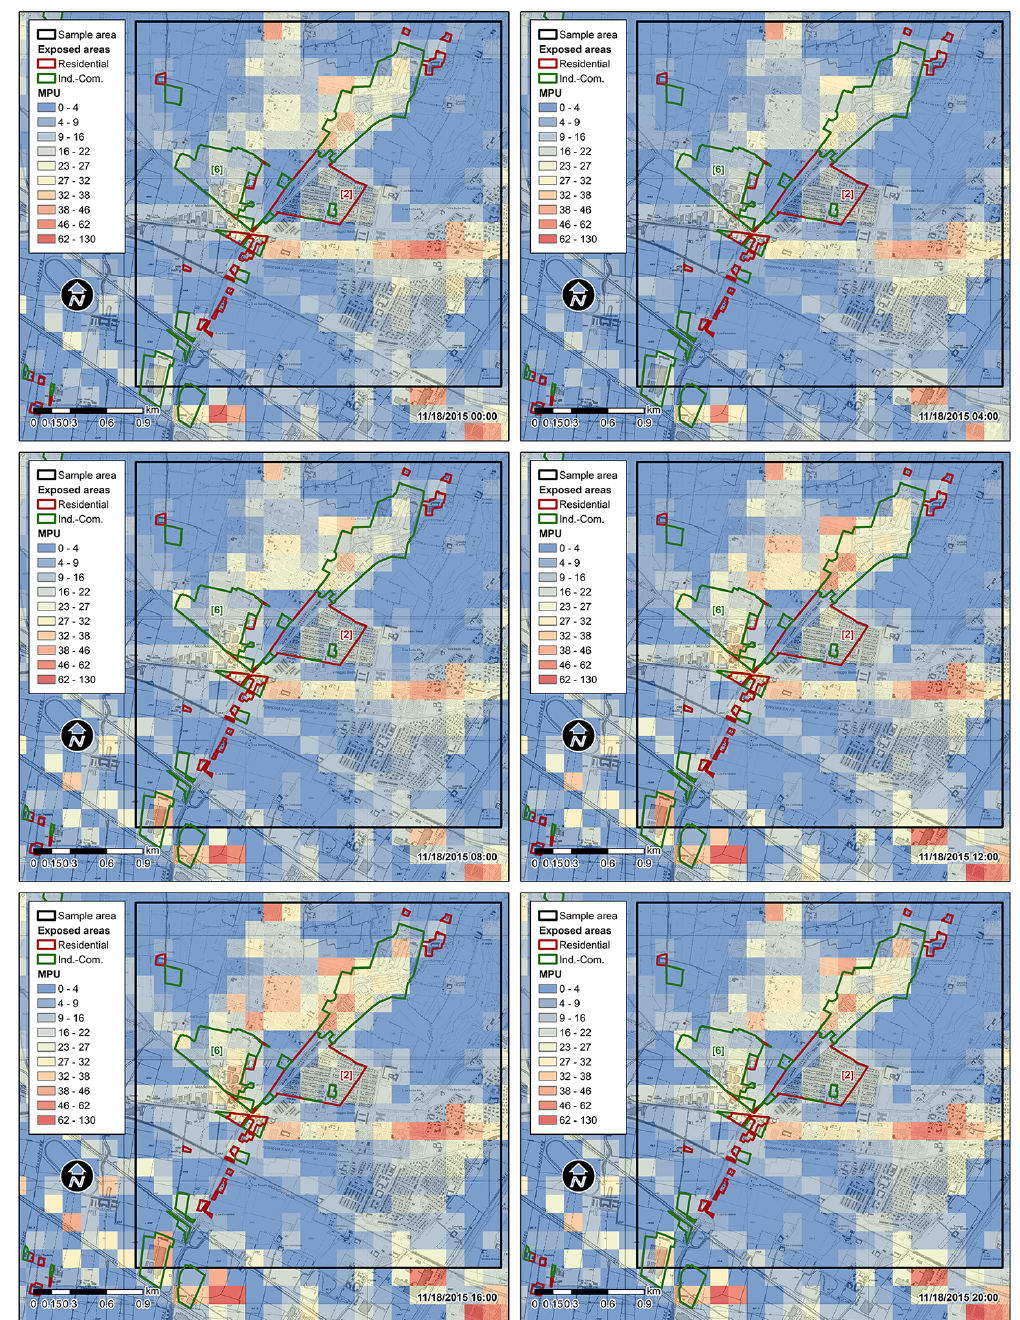
Figure 3. Snapshots of a dynamic map showing the spatiotemporal distribution of mobile phone users (MPUs) that occurred on 18 November 2015 (Wednesday) in urban areas exposed to 10-year return period flooding; the base map is the Lombardy Regional Technical Map (CTR), 1 : 5000, provided by Lombardy Region (http://www.geoportale.regione.lombardia.it/, last access: 3 March